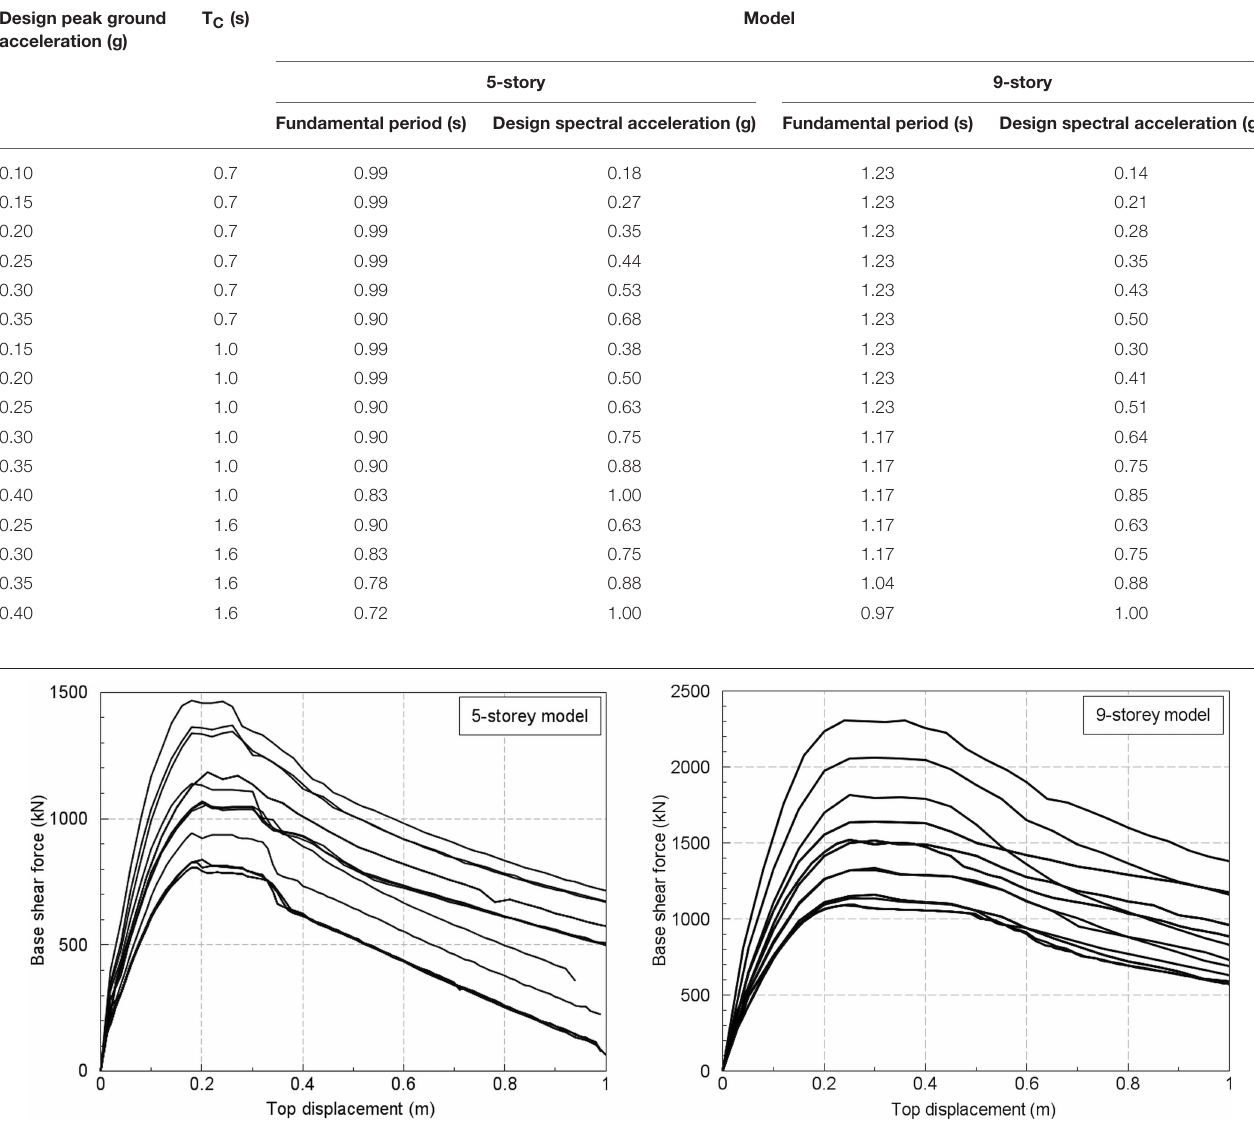
TABLE 2 | Design peak ground acceleration, design spectral acceleration, fundamental eigenperiod, and control period T C for the analyzed structural models. Design peak ground acceleration (g)